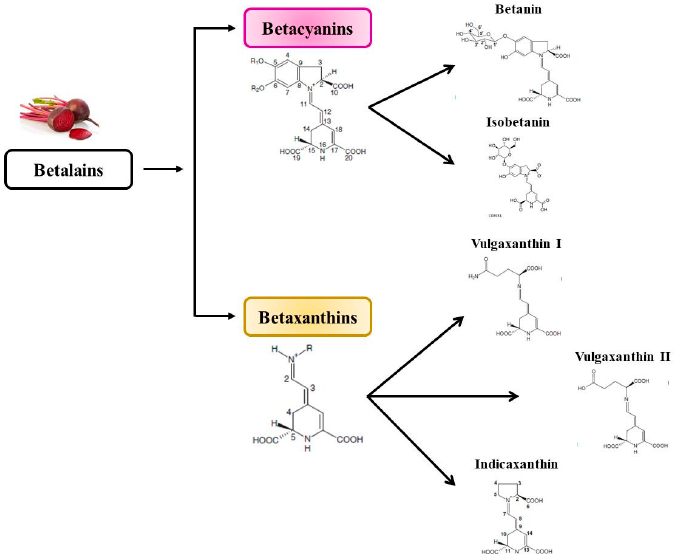
Figure 3. Classification of the two main groups of betalains present in beetroot. All the chemical structures included in this figure were obtained from Khan et al., 2015